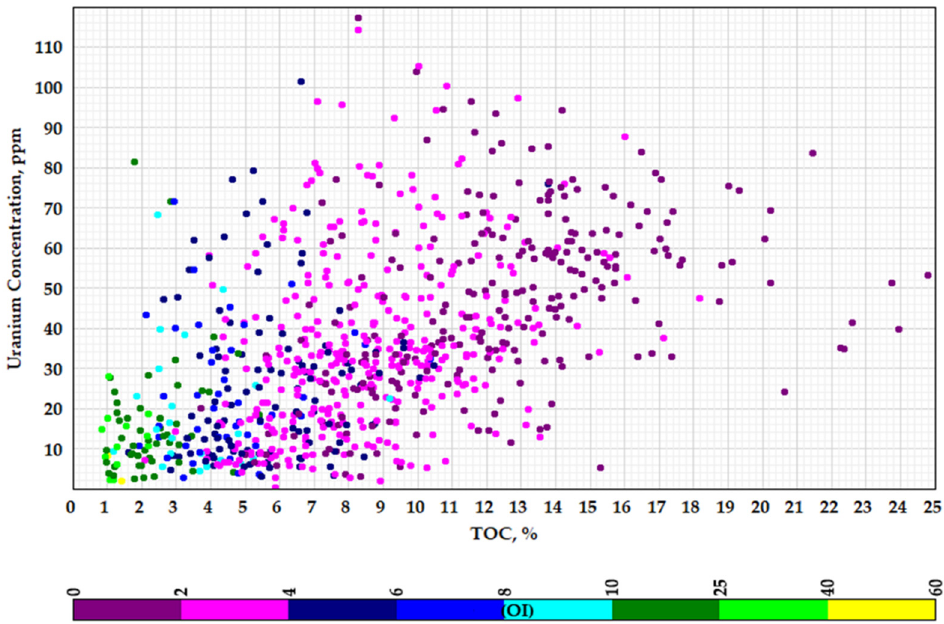
Figure 8. Cross-plot of uranium concentration (measured by gamma-ray spectrometry on core samples) and TOC (total organic carbon) according to the study of 11 wells. Dot color corresponds to the values of OI (oxygen index).